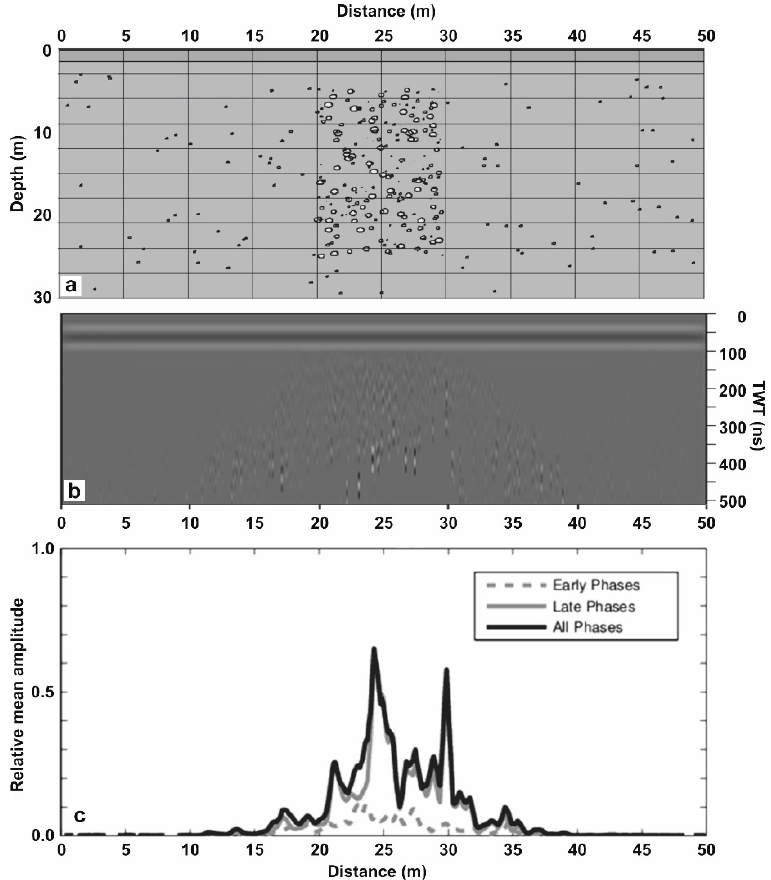
Figure 9. ( a ) Model used in the second simulation; ( b ) synthetic traces and ( c ) mean amplitude of Incoherent Energy for the profile.